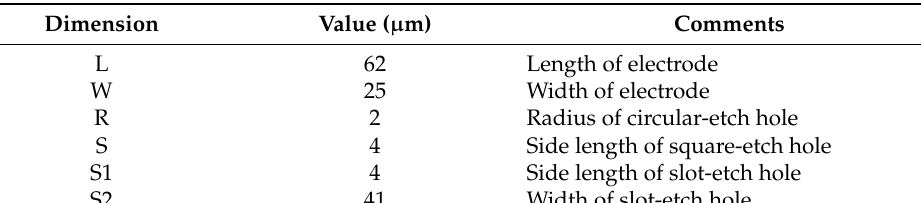
Table 1. Structural parameters of four top electrodes.